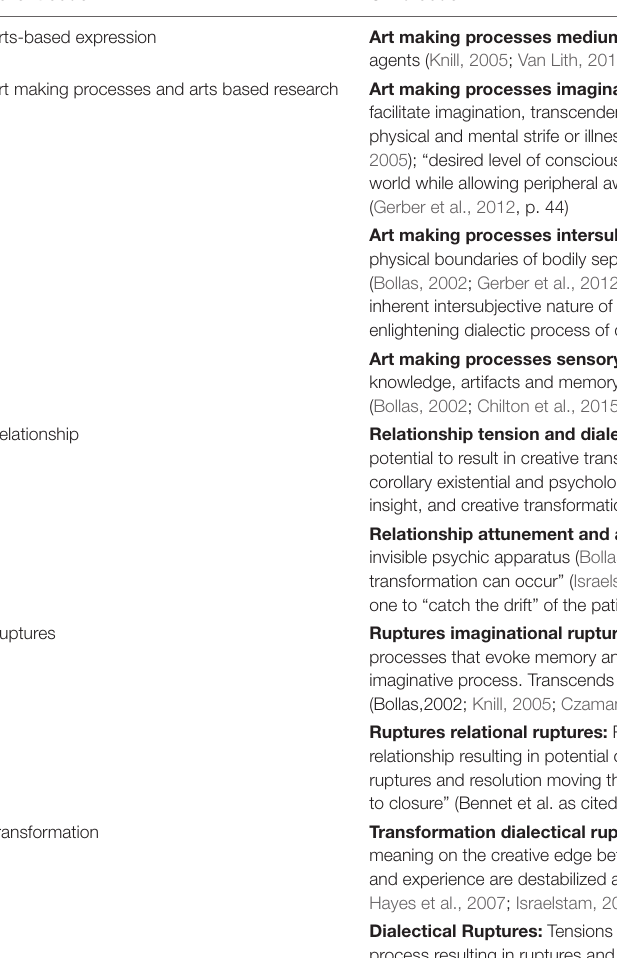
TABLE 2 | Preliminary data sets with a priori definitions. Parent code Child code Arts-based